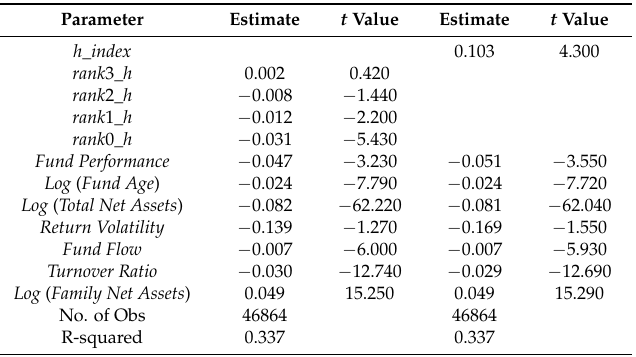
Table 8. Competition and marketing expenses, fund family fixed effect